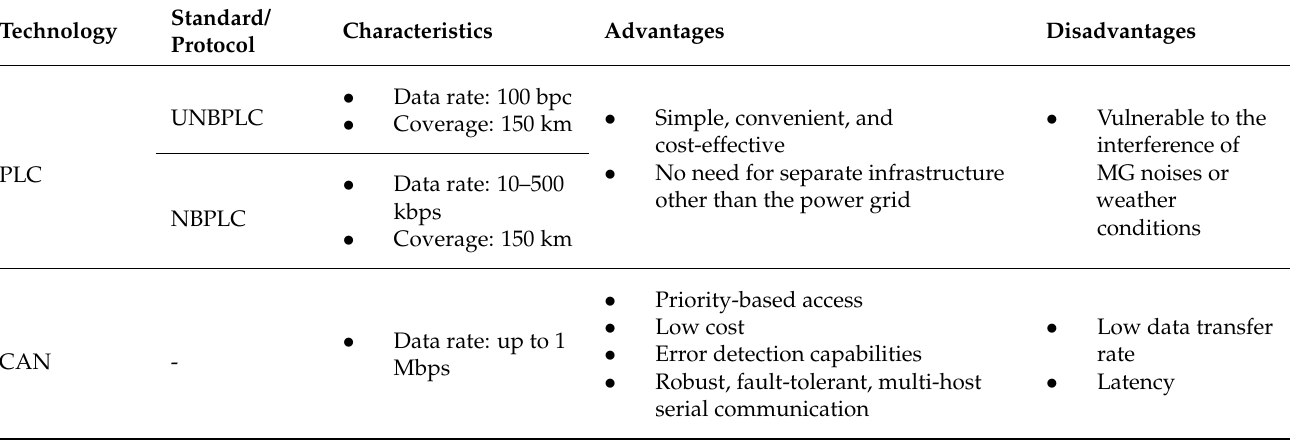
Table 11. Characteristics of LB wired technologies for the MGs communication